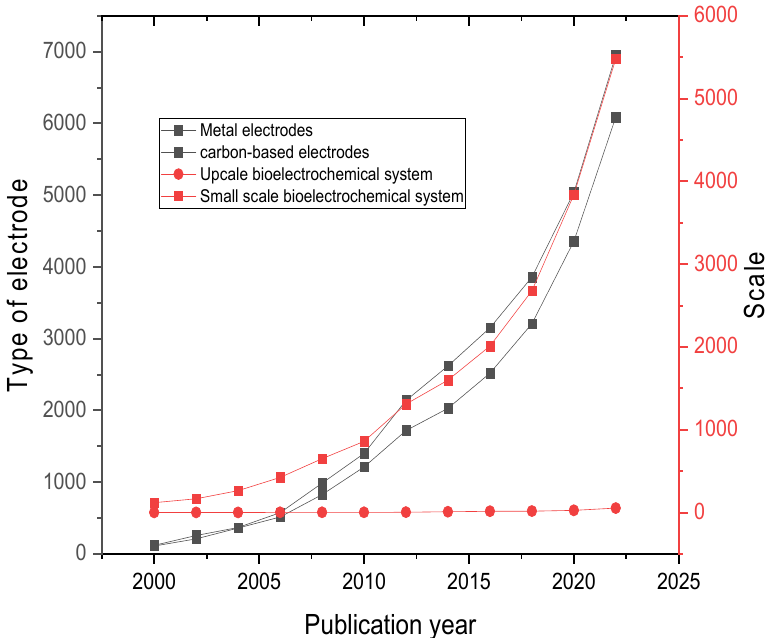
Figure 2. Google scholar publication trend of type of electrode and scale from 2000–2022.